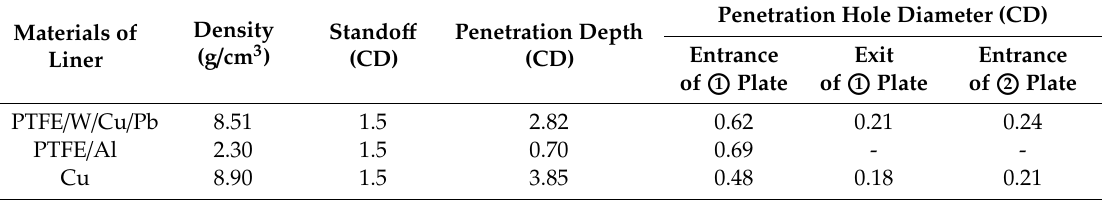
Figure 11. Experimental results of the copper jet against the steel target (on the left is the entrance hole view of the steel plates; on the right is the section view of the steel plates). Table 2. Comparison of experimental results for di ff erent